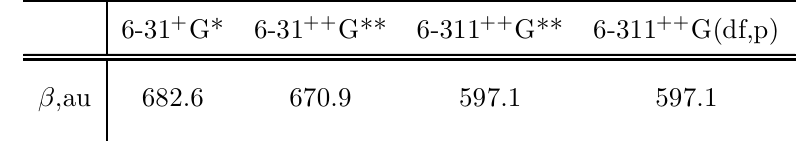
Table 2 Dependence of hyperpolarizabilities of 1a on basis